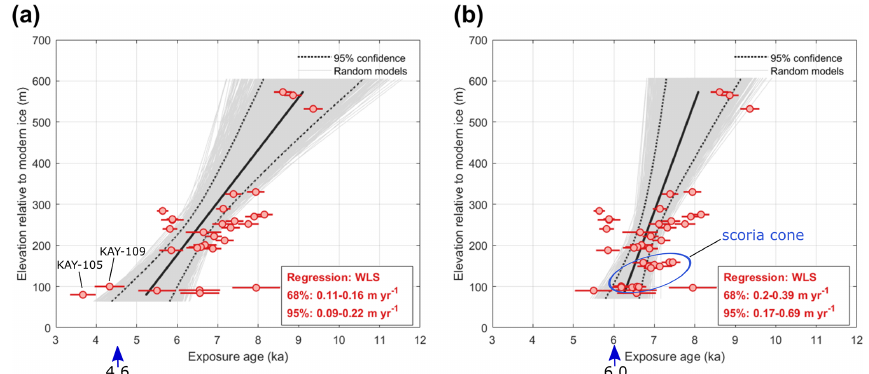
Figure 6. Linear regression models of ice surface lowering over time (ka) relative to the modern ice surface (m). (a) Results of linear regression analysis using the same exposure ages as Johnson et al. (2020). (b) Results of linear regression analysis using new scoria cone 10 Be exposure ages with KAY-105 and KAY-109 outliers removed. In both panels, exposure ages are plotted relative to elevation above the modern ice surface and display (1 σ) external errors. Modern ice surface elevations are as reported in Johnson et al. (2020) and using 80ma.s.l. as the modern ice surface elevation adjacent to the scoria cone site. The dotted black lines delimit the 95% confidence intervals of the linear regression analysis (also shown in Fig. 5b). The straight black line displays the model best-fit line, and grey lines represent all model fits to the data. Surface exposure age elevations were input normalised to the height above the modern ice surface at Kay Peak (80m). The blue arrows indicate the time when the ice surface reached its current elevation based on extrapolation of the best-fit line for each transect. The blue ellipse in (b) indicates the position of scoria cone exposure ages on the linear regression transect. See Fig. B2 for the linear regression models generated from sample sets 2 and